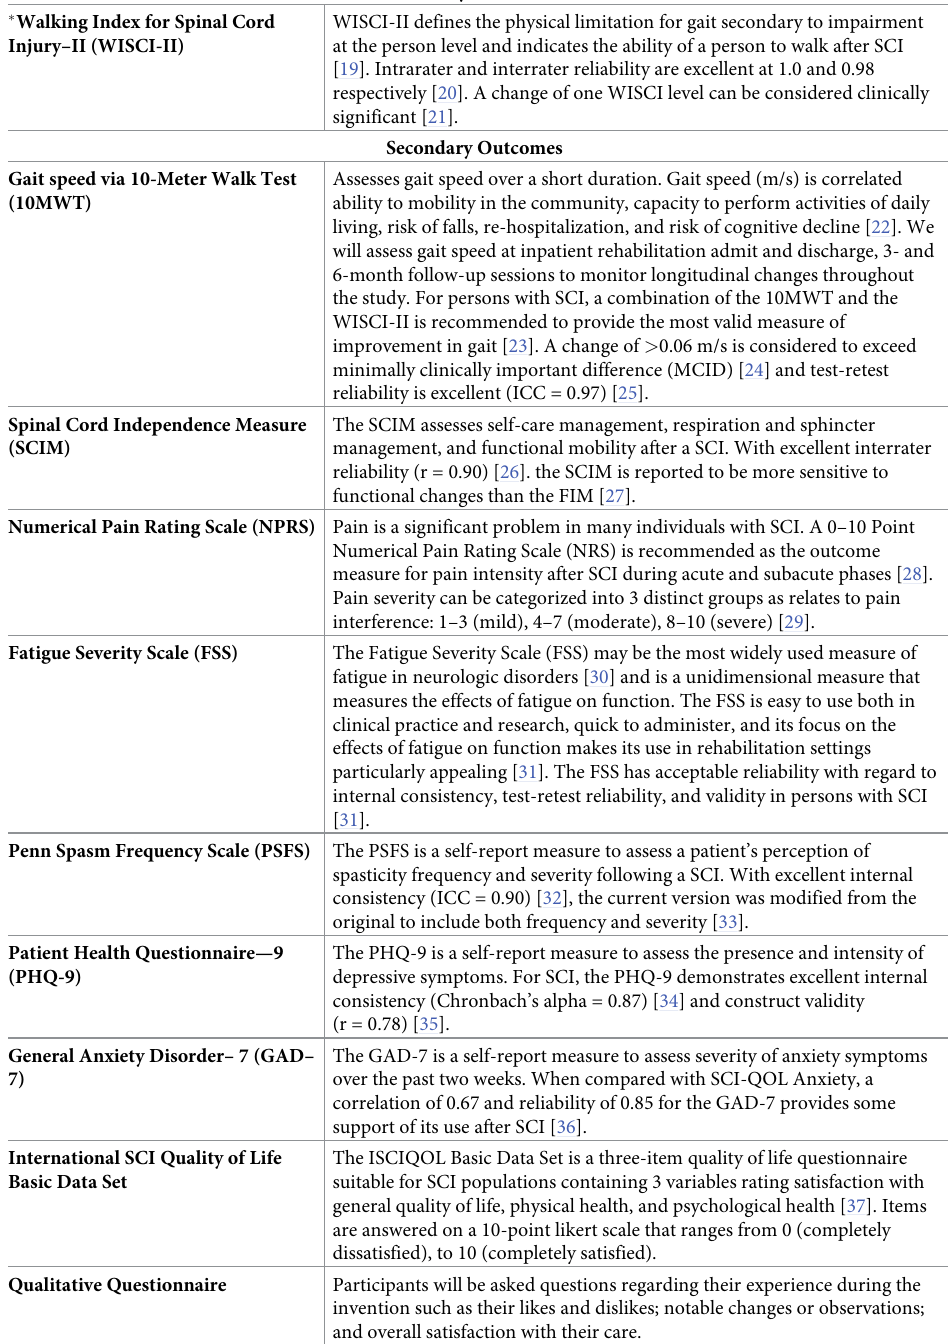
Table 2. Outcome measures for proposed project and link to